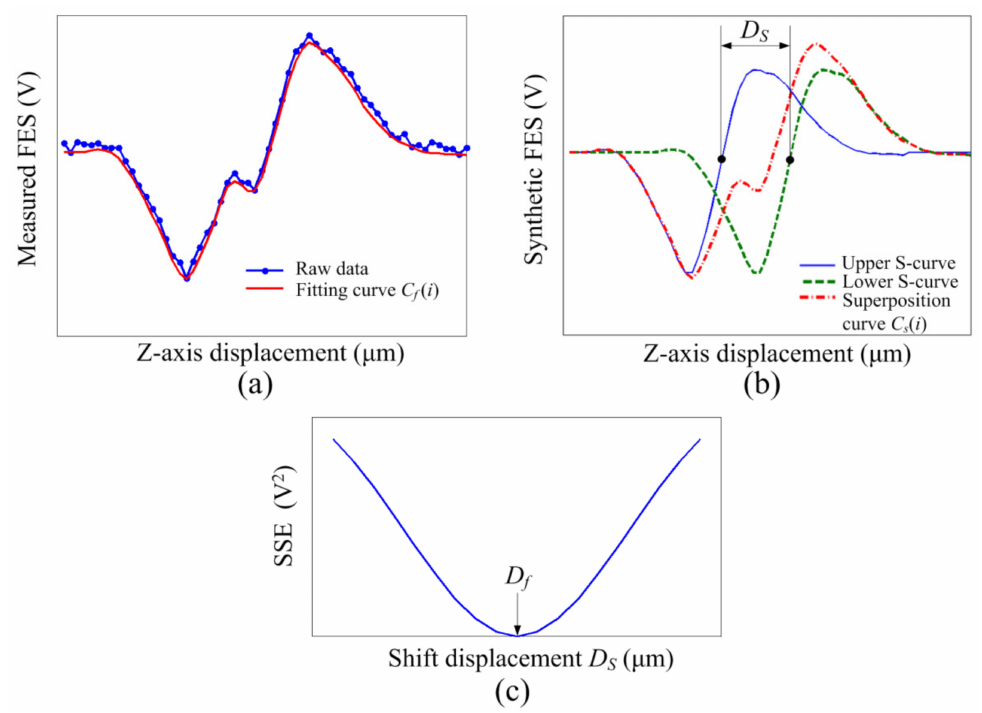
Figure 2. ( a ) FES vs. z -axis displacement curve illustrating coupling problem. ( b ) Synthetic curve from two S-curves. ( c ) Sum of squared error vs. D s